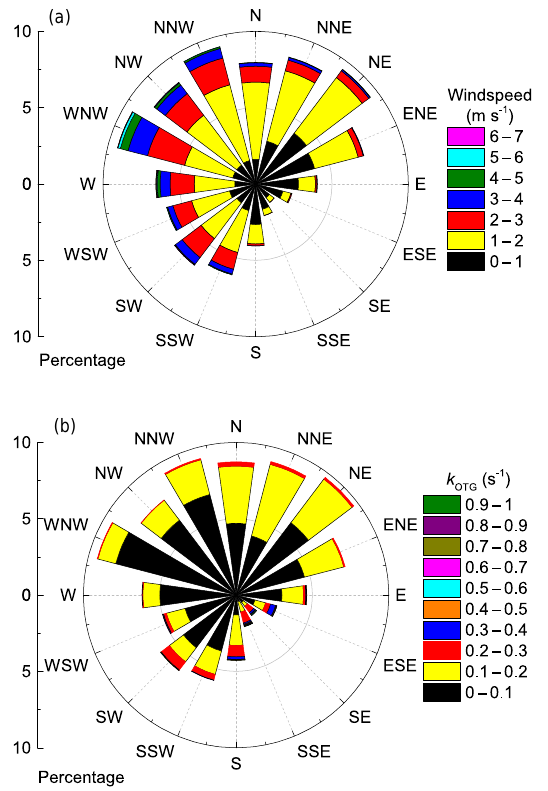
Figure 3. (a) Wind rose coloured according to wind speed. (b) Wind rose coloured according to k OTG